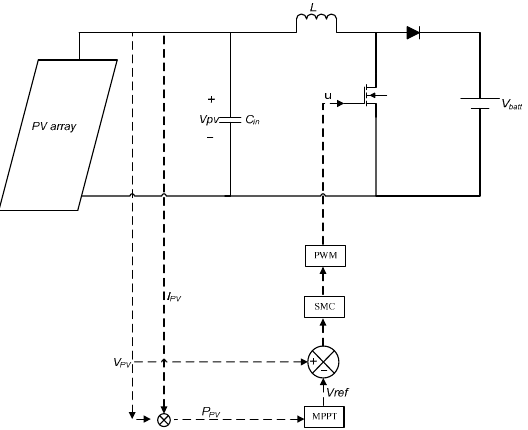
Figure 2. System scheme based on the improved sliding mode controller (SMC).